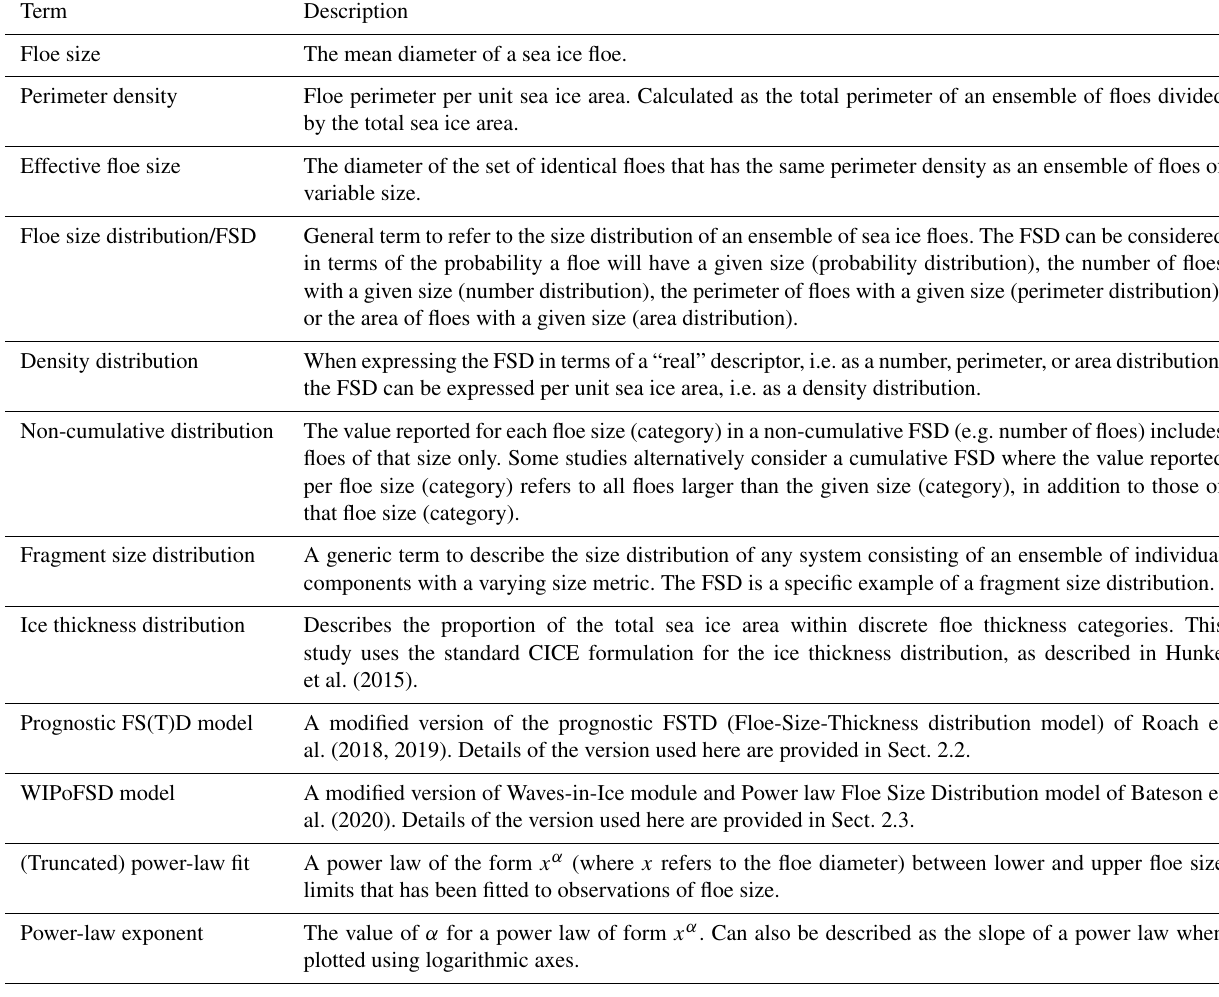
Table 1. A summary of important terms related to the sea ice floe size distribution (FSD) that are used within this study. Note that these terms are defined in the context of this study